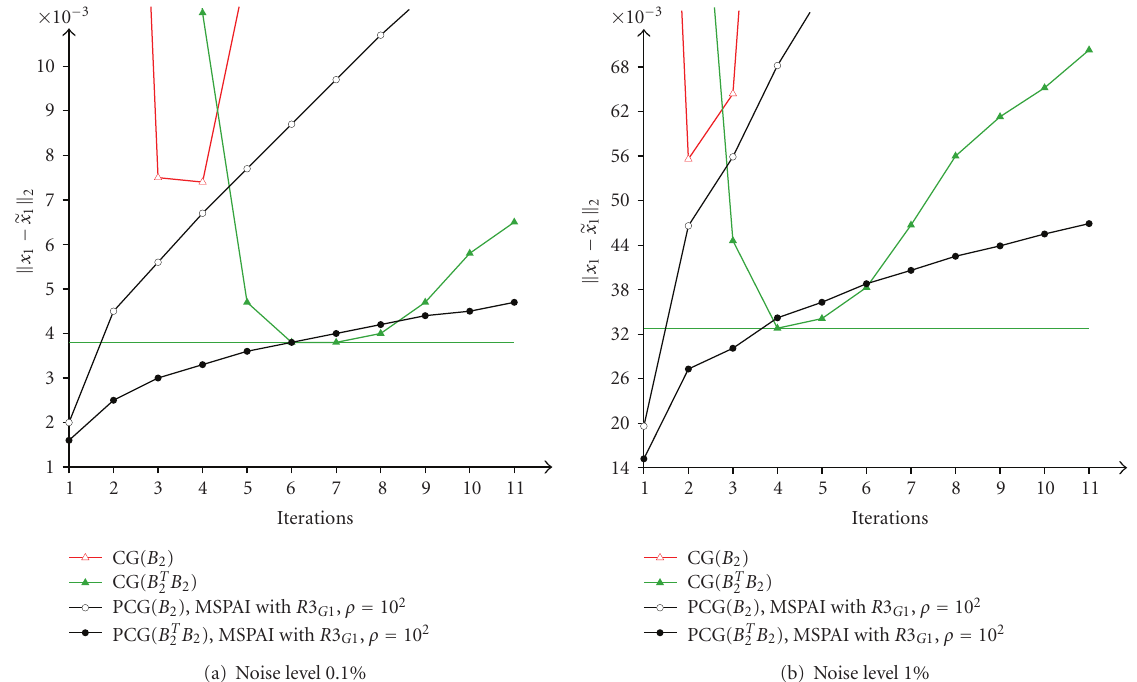
Figure 5: Reconstruction error against the iteration for the 1D blur operator B 2 and the original data x 1 of size n = 10 3 a ff ected by random noise of order 0.1% (a) and 1% (b), respectively. CG is compared to CG using the normal equations, PCG for B 2 and B T 2 B 2 using MSPAI with R 3 G 1